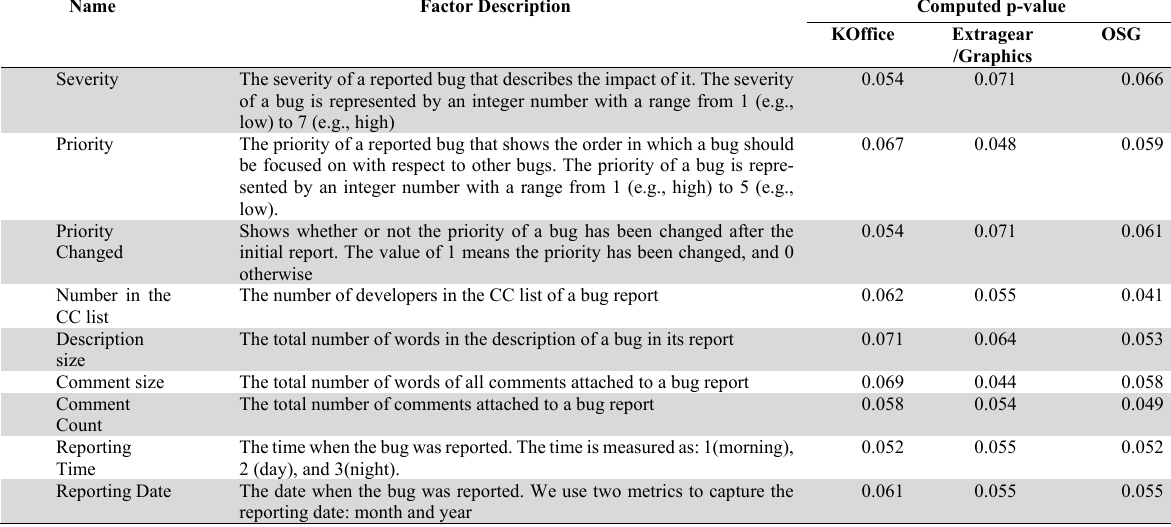
The summary of factors that show no significant difference between adaptively_fixed and non_adaptively_fixed